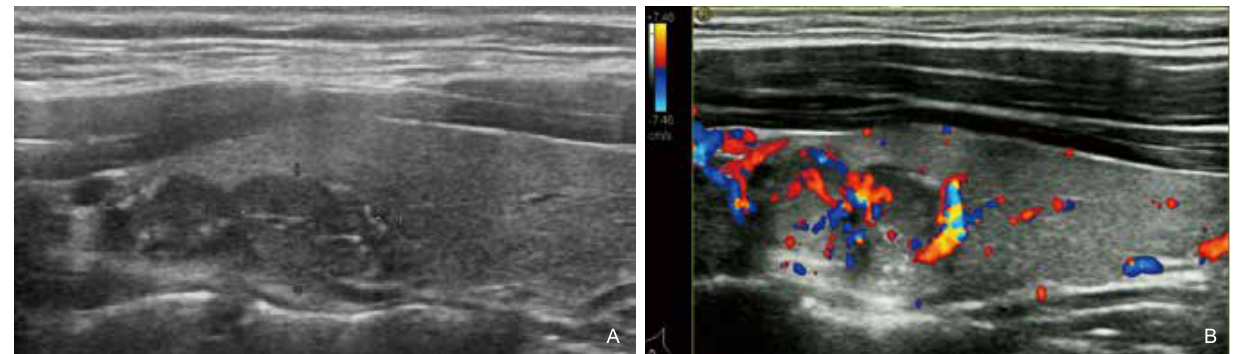
Figure 1 Ultrasonograms of a papillary carcinoma-suspected left thyroid nodule. (A) A moderately-defined hypoechoic nodule in the middle-upper part of the thyroid with scattered strong echoes and slight posterior enhanced echoes. (B) Display of color signals within the partial parenchyma of the nodule on CDFI mode.